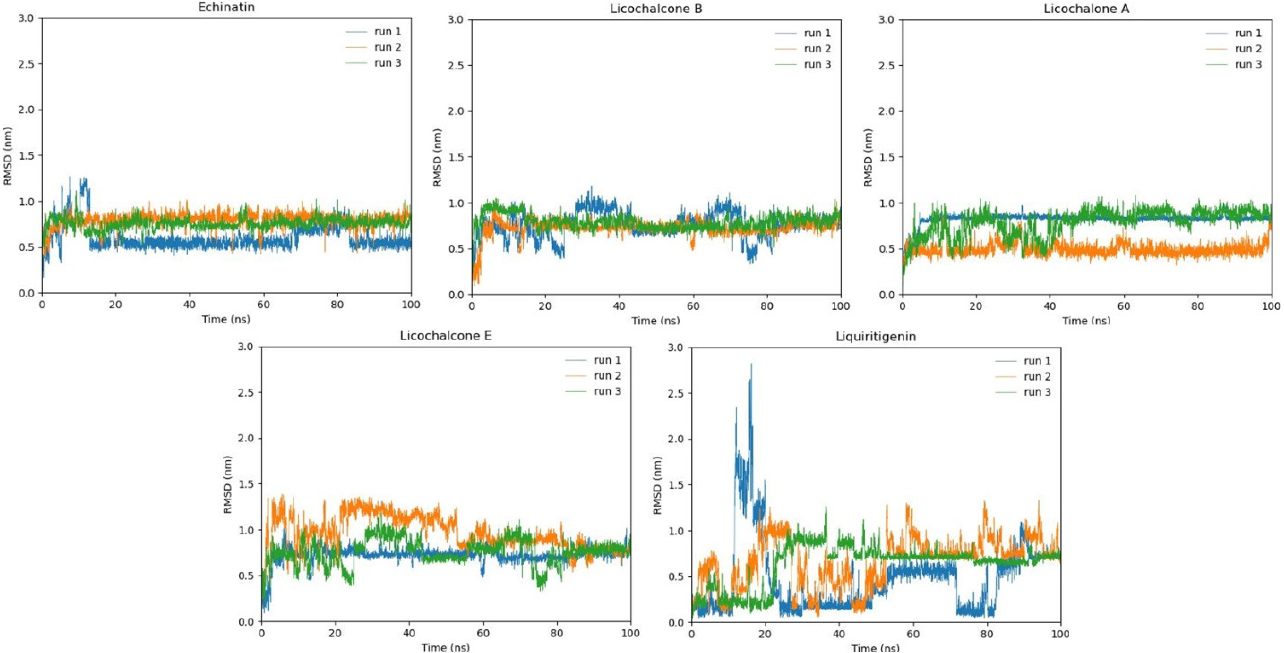
Figure 10. The graph exhibits the root mean square values of five selected compounds throughout a 100 ns MD simulation period. Three runs are indicated by different colors: run1 is indicated in blue color, run2 is exhibited in orange color, and run3 is determined by light green color. All three runs manifest RMSD values for 100 ns carried individually.